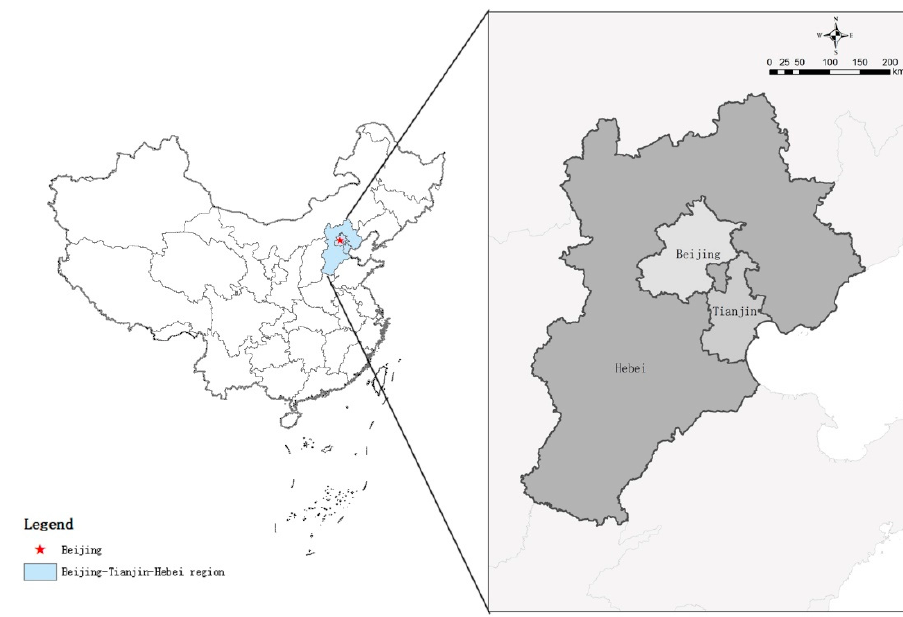
Figure 4. Location of the BTH region in China. Source: Drawn by authors. (BHT: Beijing-Tianjin- Hebei.).